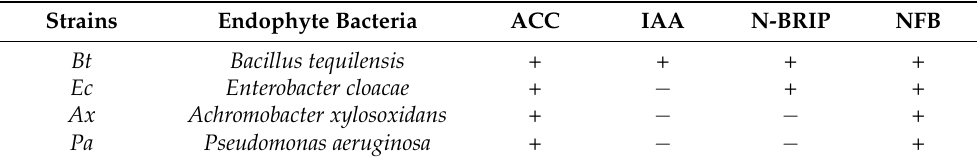
Table 1. Plant growth promoting properties of endopyte bacteria used for biocompatibility